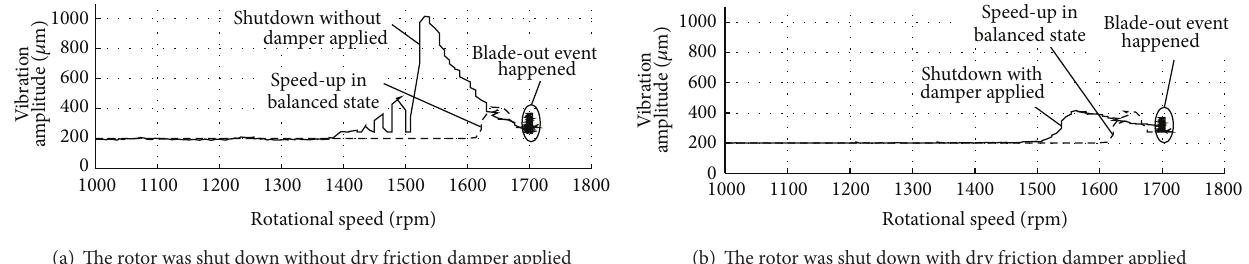
Figure 19: The rotor protection by elastic support/dry friction damper during shutdown.